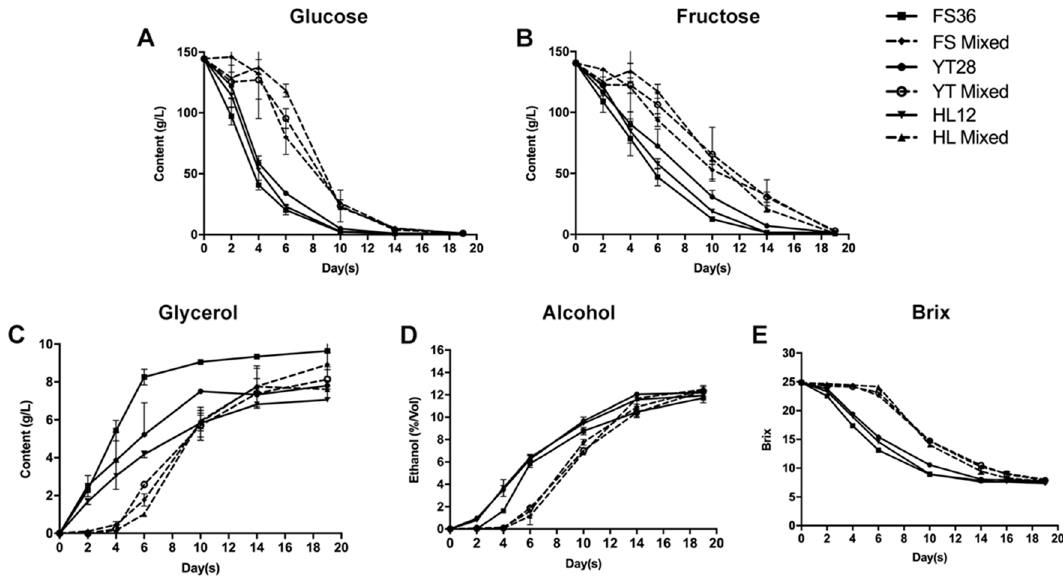
Figure 1. The basic parameters of six Marselan wines during fermentation.